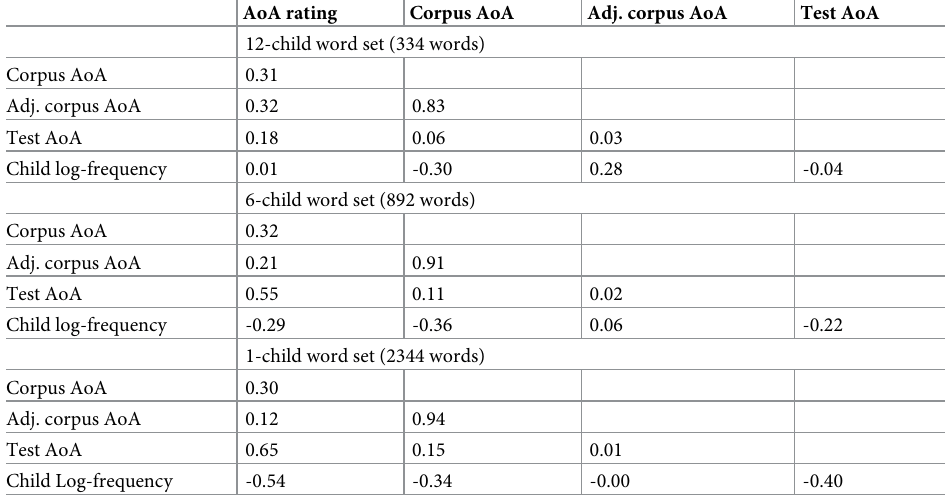
Table 1. Correlations between adult AoA ratings, raw and adjusted corpus AoA estimates, and children frequency.